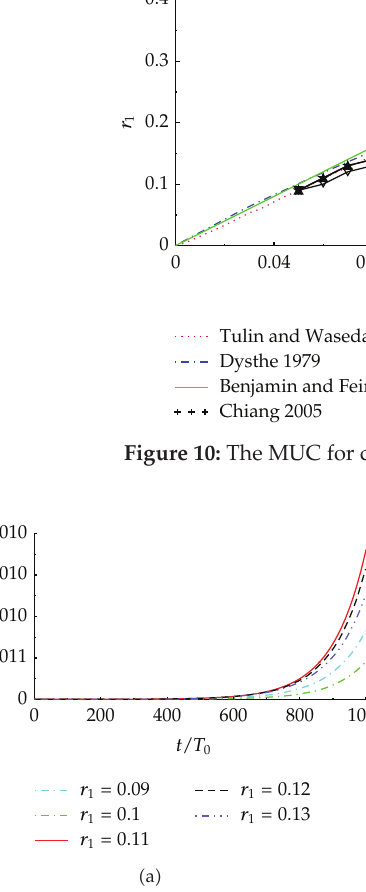
Figure 11: The sideband evolution processes from the background noise for “un-seeded” wave system with case ε 0 (cid:7) 0 .